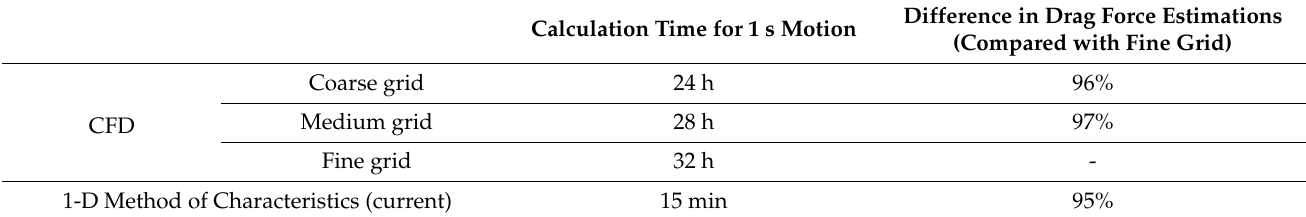
Table 3. Comparison of computational time for 1-sec travel